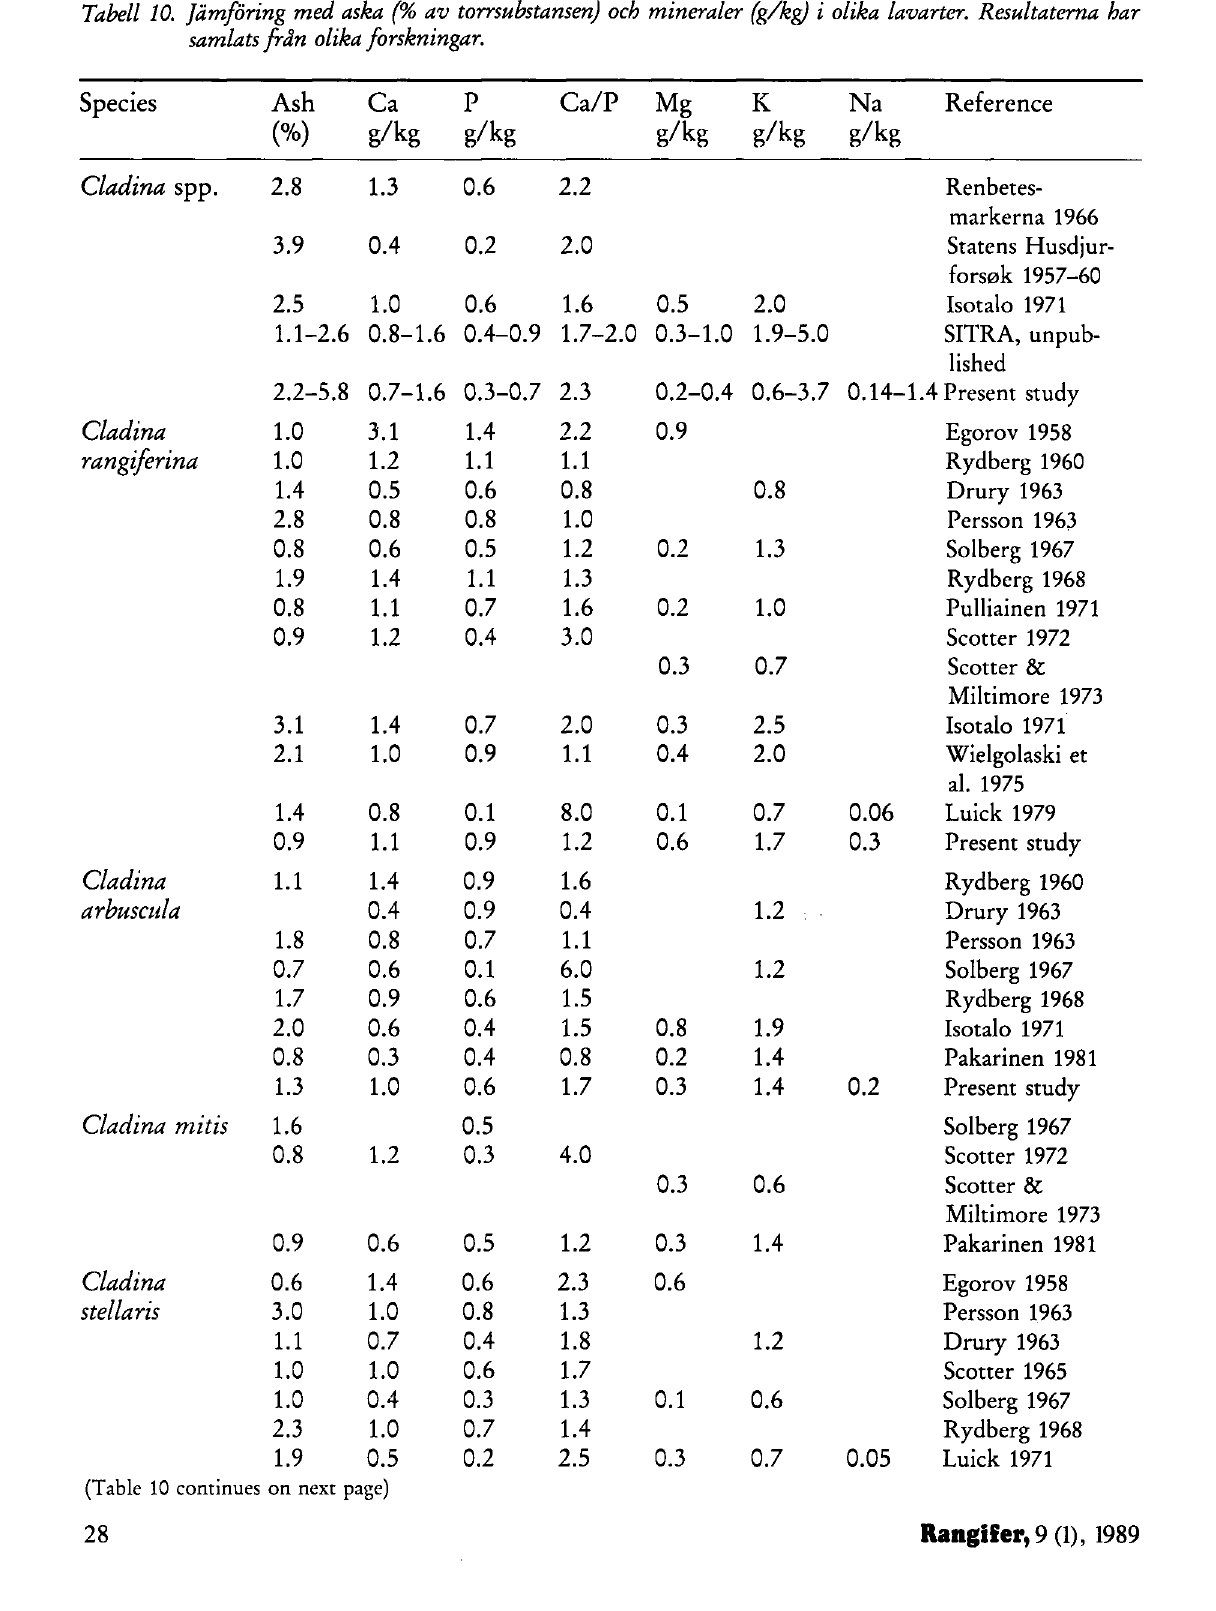
Table 10. Comparison of ash (% DM) and mineral contents (g/kg DM) in different lichens. Results are collected from different